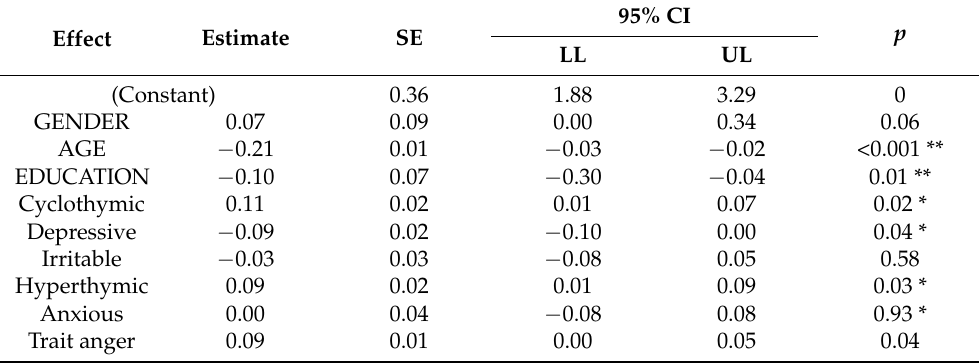
Table 3. Multiple regression analyses with the study’s predictors (age, gender, education temperament traits and state anger) of preference for rap